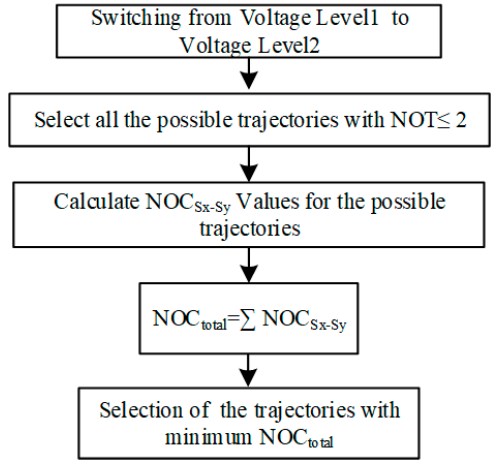
Figure 11. Search for the minimal number of commutations.